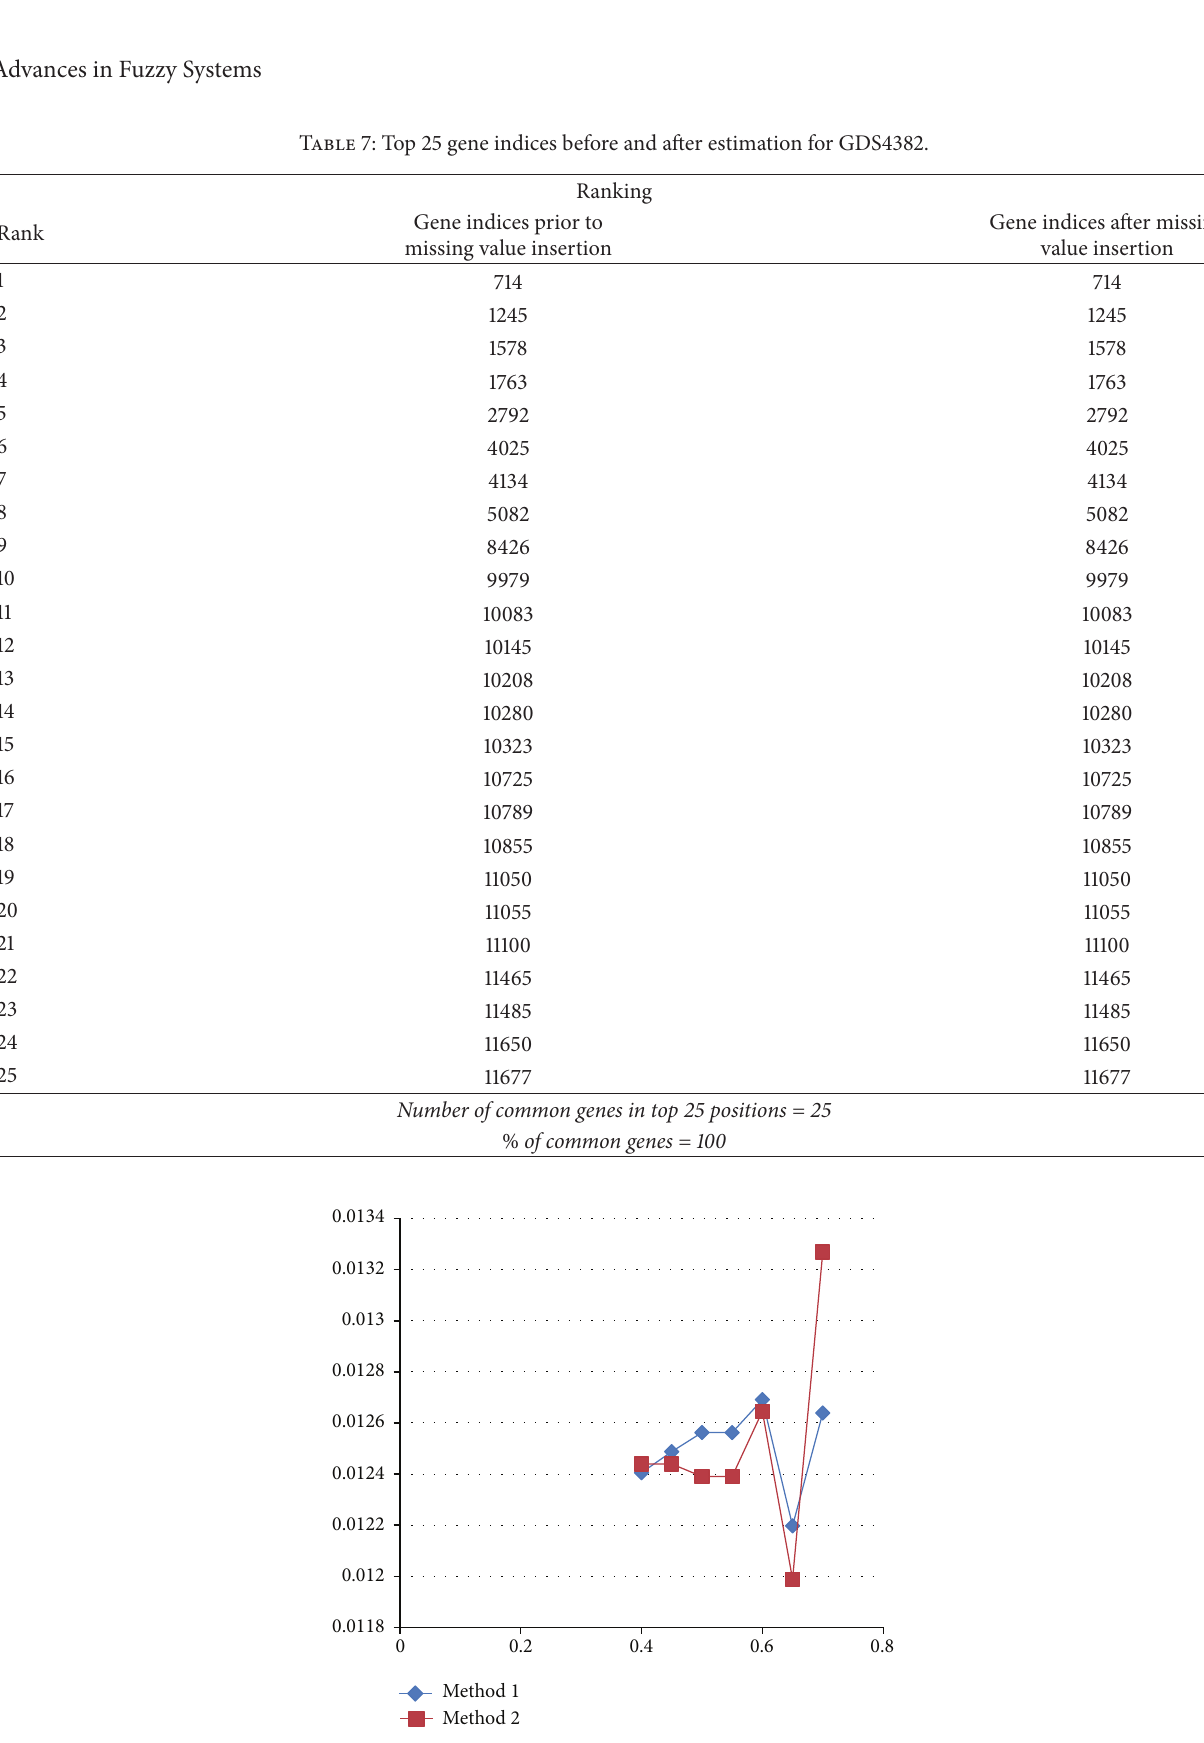
Figure 3: Plot of RMSE versus membership grade 𝜃 for alpha